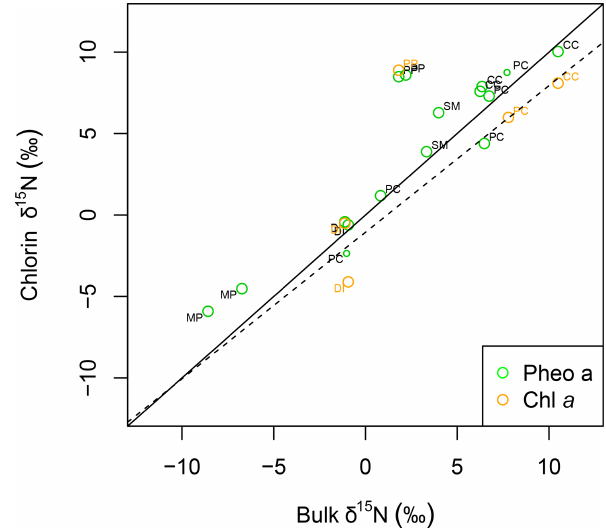
Figure 3. Patterns in isotopes of bulk material (open circles) and pheo a extracts (closed triangles) from plant leaves (Veg, green), litter (black), and soil (red). Deep soils (blue) have a depth of greater than 30cm and only one pheo a isotope measurement was made for these samples. Lines connect site averages between bulk (solid) and pheo a (dashed) measurements.